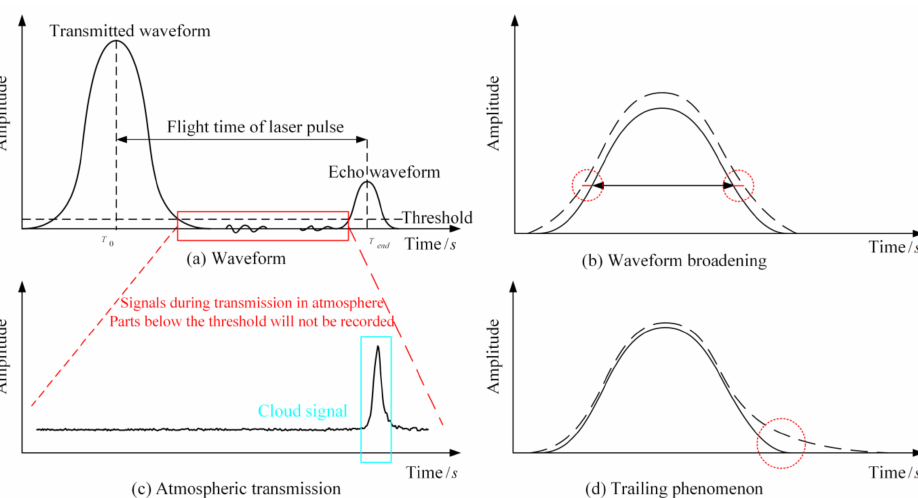
Figure 8. Influences of atmospheric scattering on laser altimetry data. ( a ) shows the transmitting waveform and receiving waveform of GF-7 laser system; ( b ) shows the waveform broadening caused by atmospheric scattering;( c ) shows the process of capturing cloud signals by laser al- timetry system, but GF-7 does not have this ability; ( d ) shows the tailing phenomenon caused by atmospheric scattering.